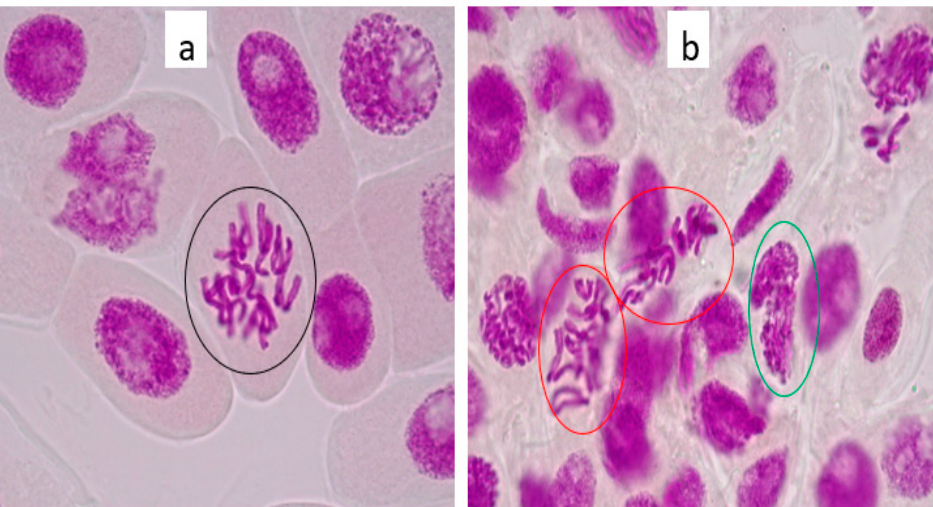
Figure 5. ( a ) tap water control cells showed normal mitosis phase (anaphase) in root tip meristem indicated by the black encircled picture. ( b ) showed irregular prophase and metaphase in root tip meristem cells of Allium cepa exposed to 100 µg/L lamivudine, indicated by the red and green encircled pictures, respectively. (Onion root tip imaged at 1000× magnification).